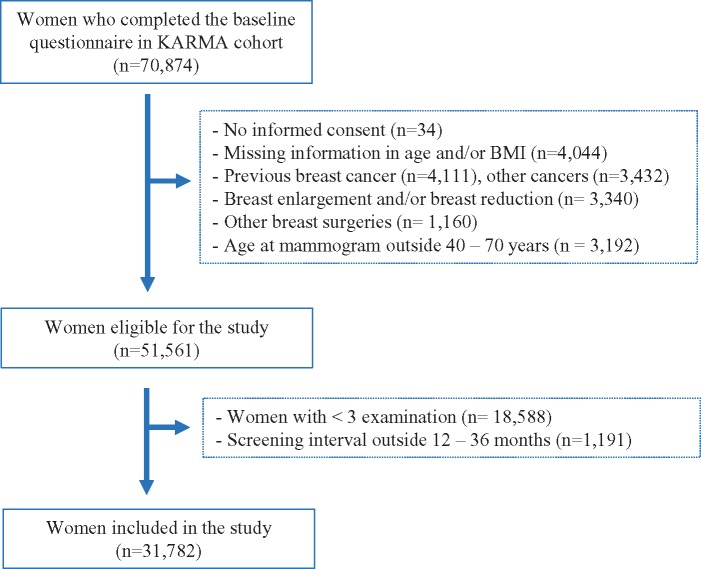
Flow chart describing the exclusion criteria for 70 874 women in the Karolinska Mammography Project for Risk Prediction of Breast Cancer (KARMA) cohort.